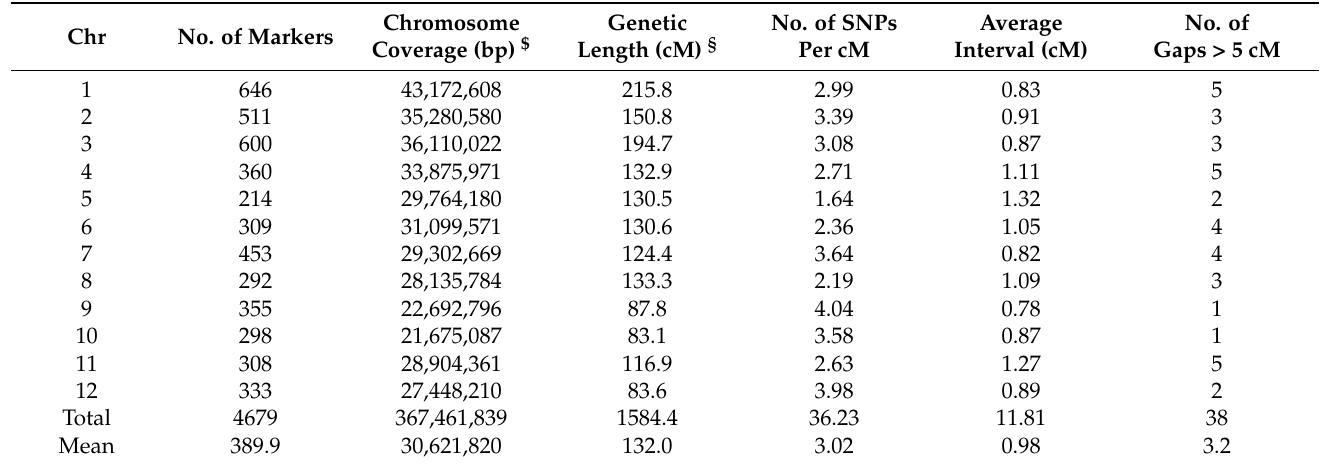
Table 3. Distribution of SNP markers and genome coverage in the linkage map of Cocodrie × Dular RIL